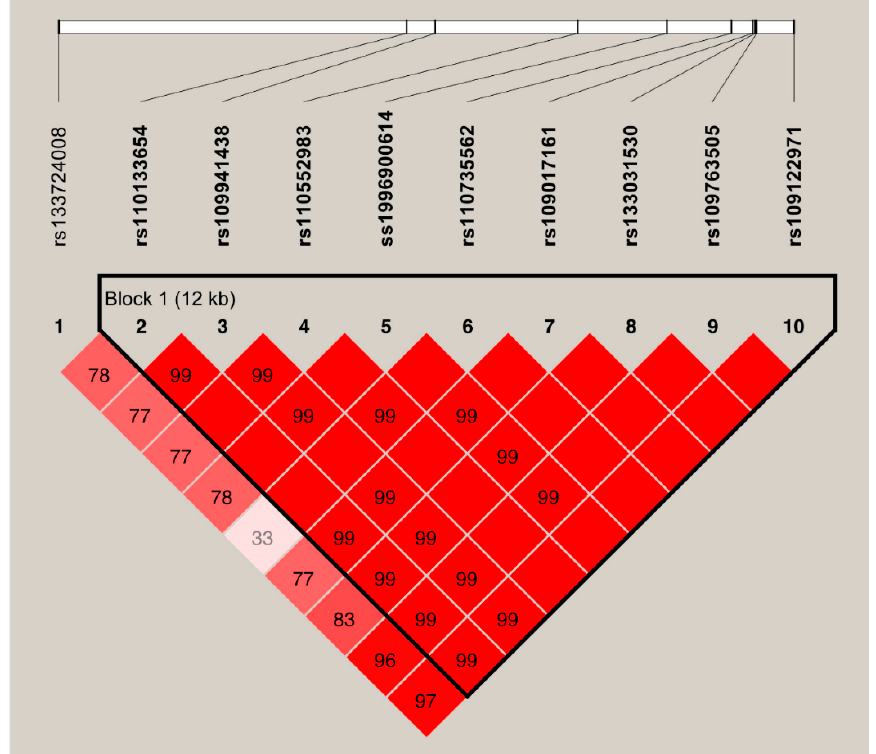
Figure 1. The haplotype blocks and pairwise linkage disequilibrium (LD) values (D ′ ) for the ten SNPs in ERBB2. Legends: The values within boxes are pair wise SNP correlation (D ′ ), bright red boxes without numbers indicate complete LD (D ′ = 1). The brighter shade of red indicates higher LD. Table 4. Main haplotypes and their frequencies observed in ERBB2 gene.